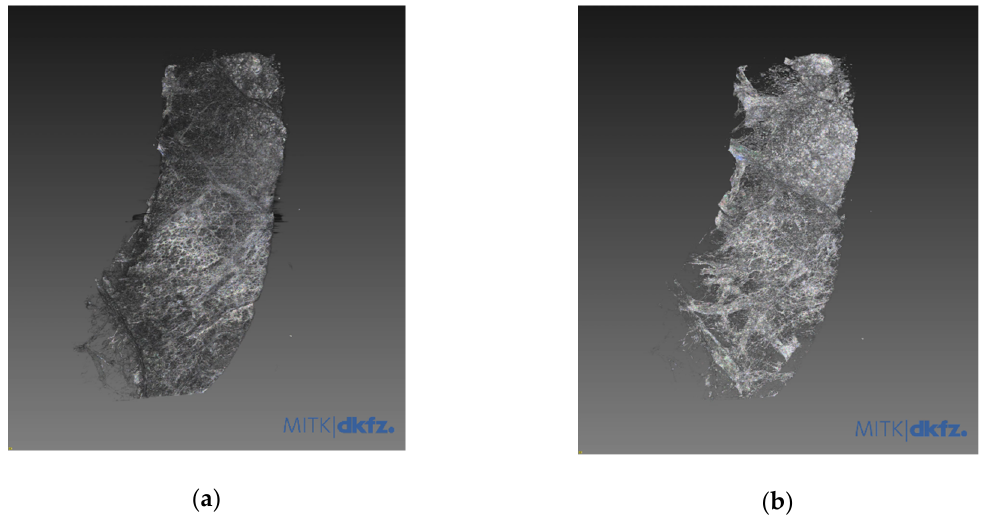
Figure 4. Three-dimensional reconstruction. ( a ) 3D image of normal human lung tissue. ( b ) 3D image of lung adenocarcinoma. Three-dimensional structures of normal lung cancer and adenocarcinoma could be easily observed through 3D reconstruction of tomographic images. The images were obtained using a 3D image processing software called the Medical Imaging Interaction Toolkit (MITK), developed by the German Cancer Research Center. Relating videoclips are appended as supplementary data.